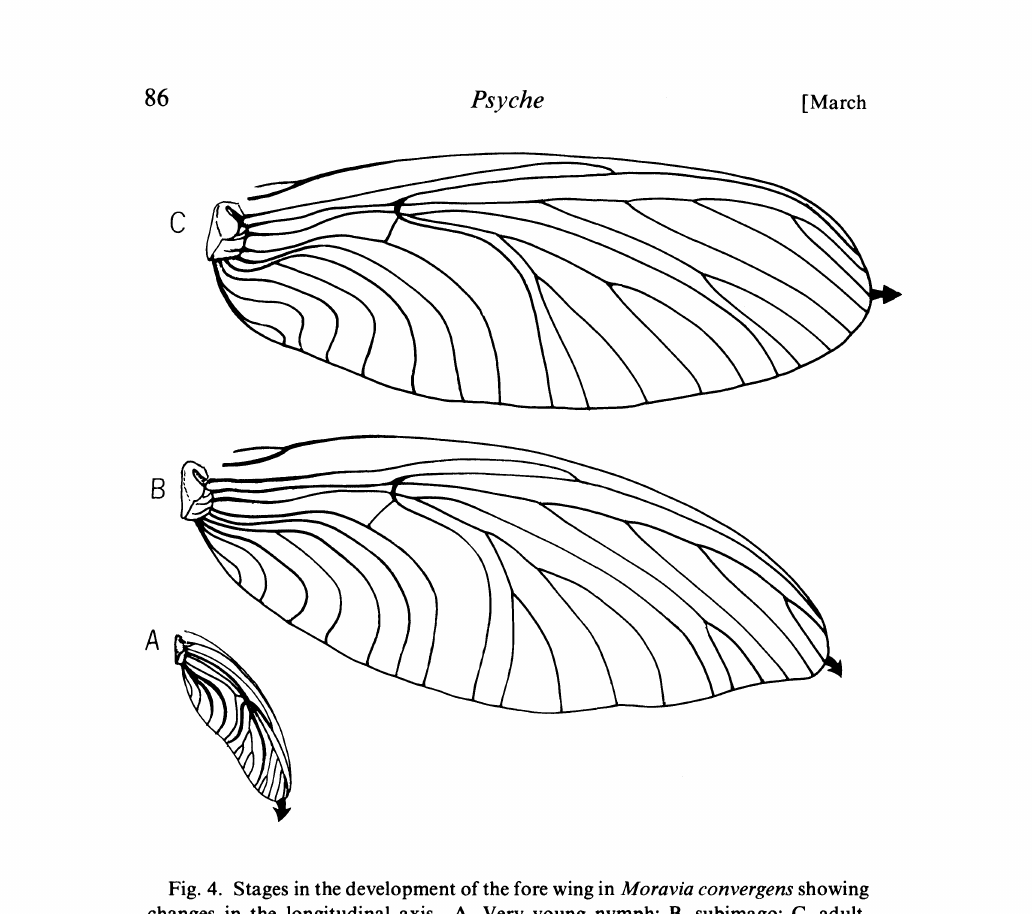
Fig. 4. Stages in the development of the fore wing in Moravia convergens showing changes in the longitudinal axis. A, Very young nymph; B, subimago; C, adult. Lower Permian of Czechoslovakia. Original.